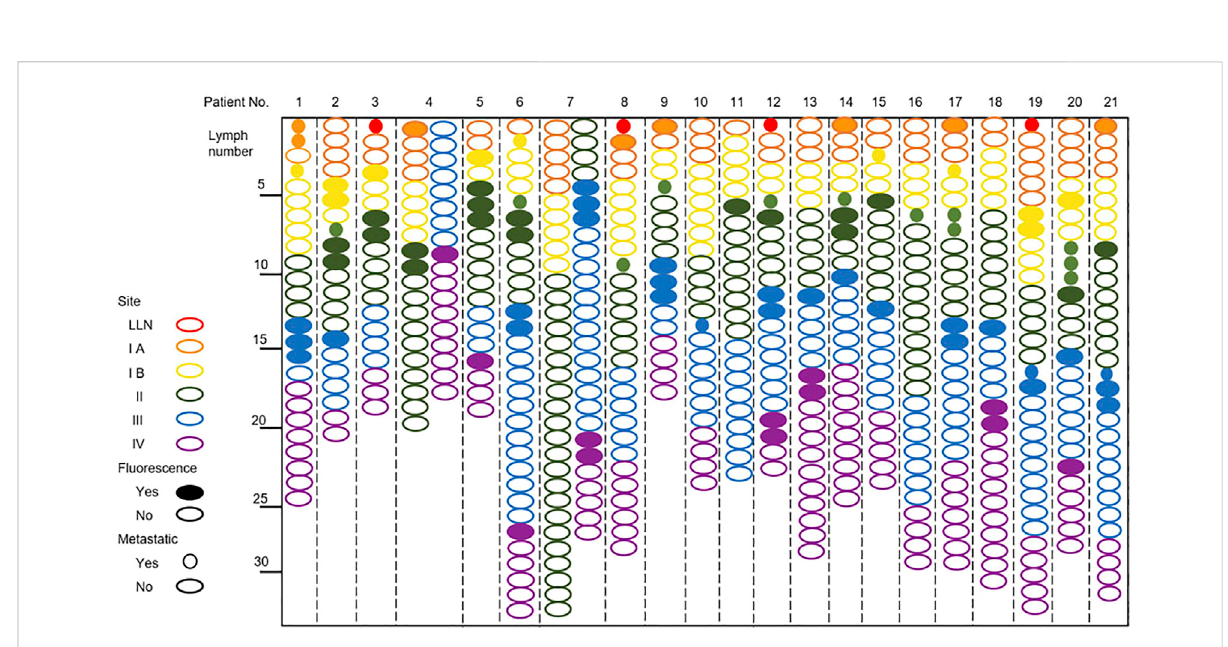
Frontiers in Cell and Developmental